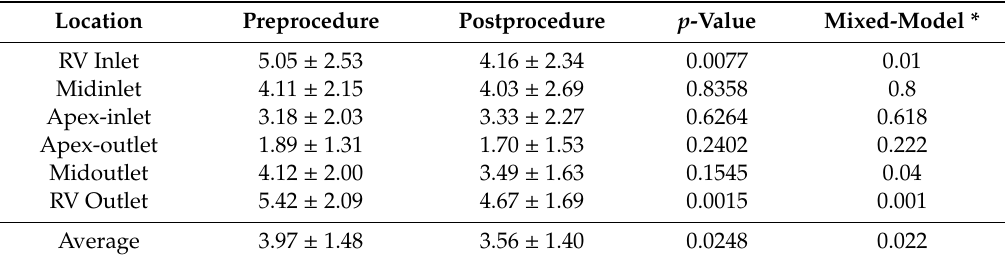
Table 2. Changes of velocity in each RV segment on VVI (cm / s) after ASD device closure.